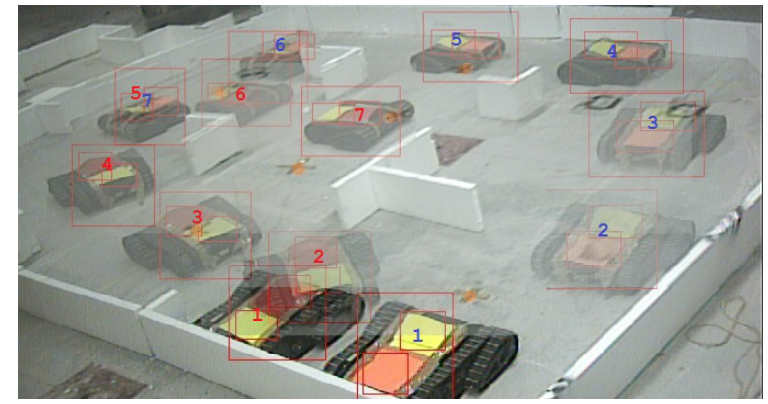
Figure 13. Deployment of two Jaguar V2 robots for multi-robot autonomous exploration experiments.